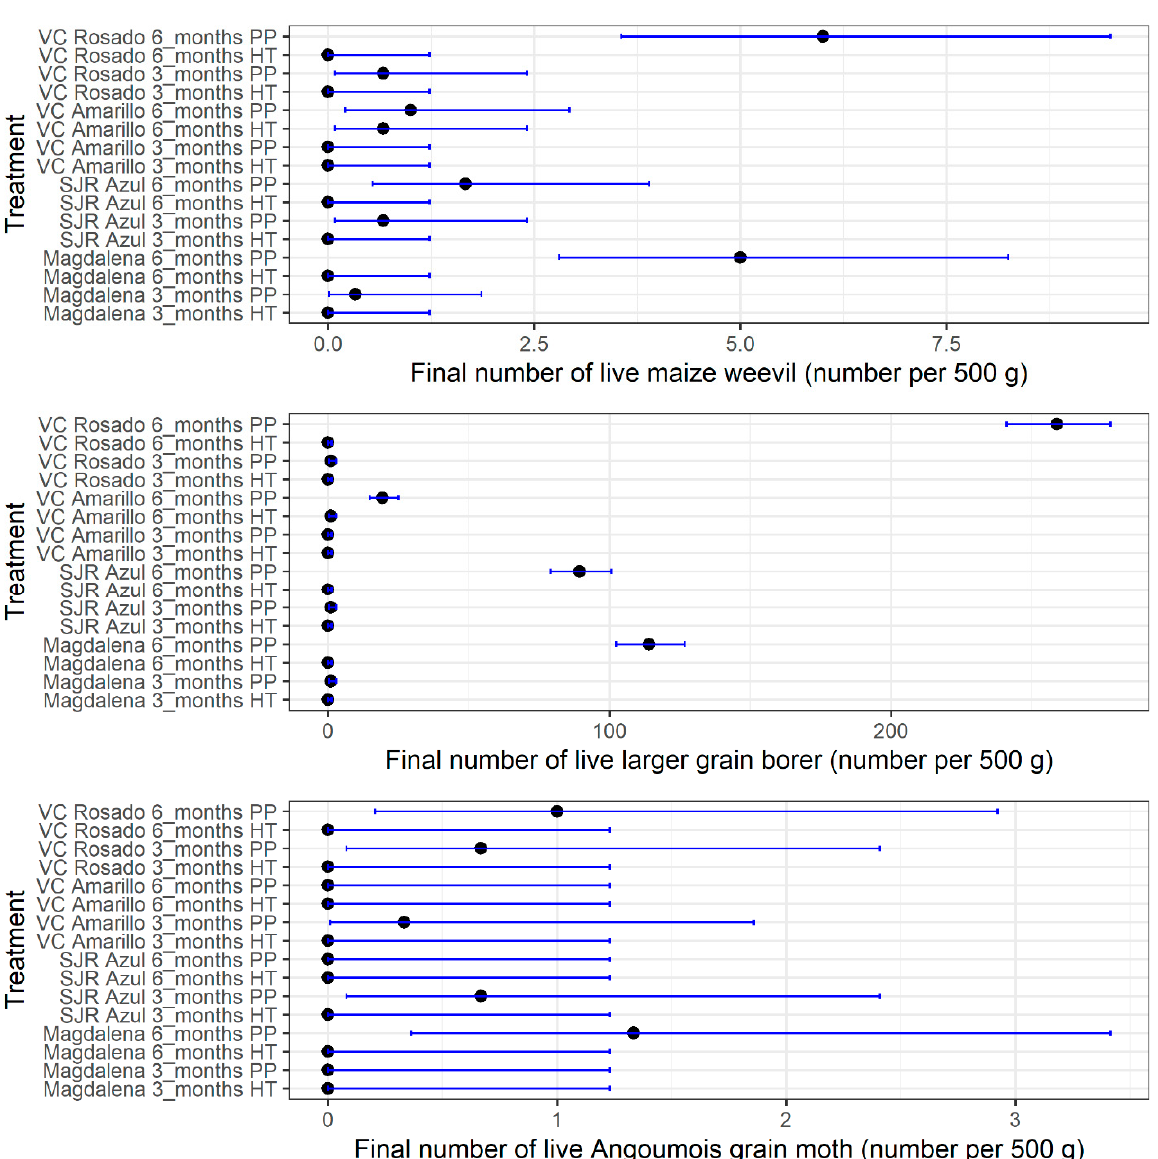
Figure 1. Poisson confidence intervals (95%) of the mean of the final number of live maize weevils ( S. zeamais ), larger grain borers ( P. truncatus ) and Angoumois grain moths ( S. cerealella ) after three and six months of storage. Legend. PP: polypropylene woven bag; HT: hermetic technologies.